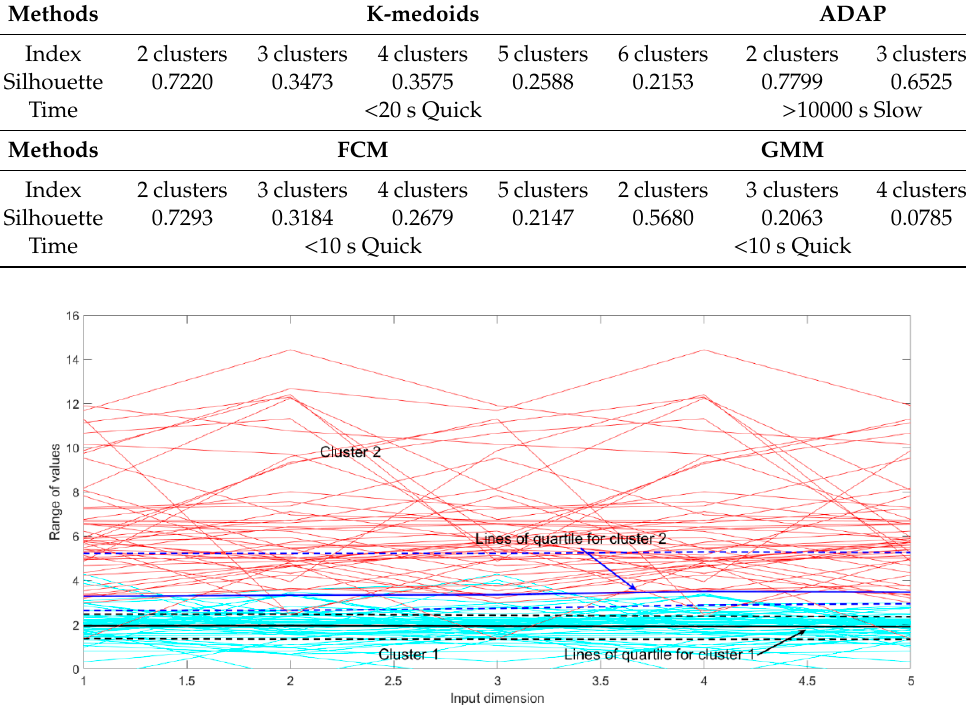
Figure 9. Display of ADAP clustering results.